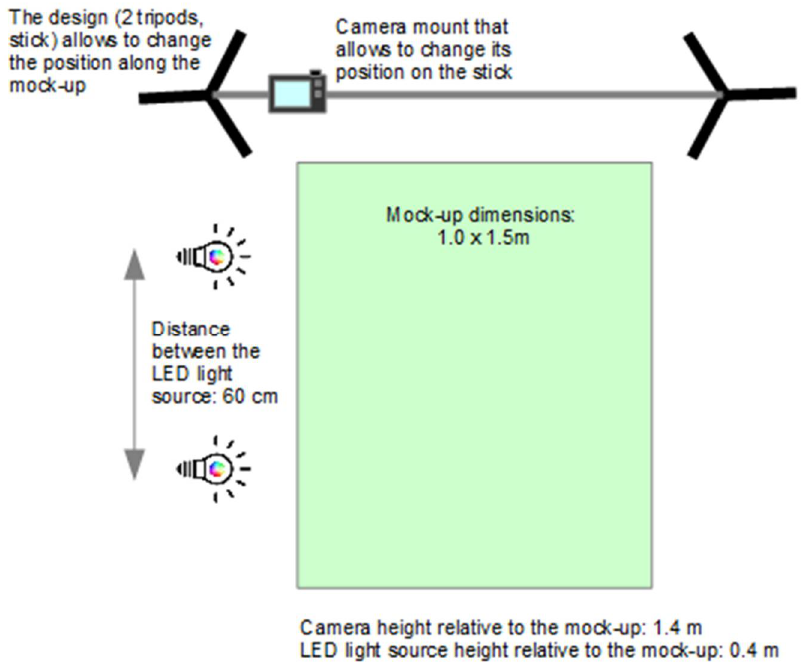
Figure 5. Measurement station.